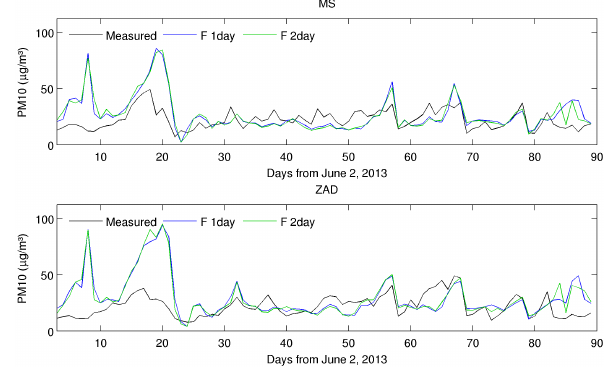
Figure 7. The same as Fig. 5 but for daily PM 10 concentrations at the MS and ZAD